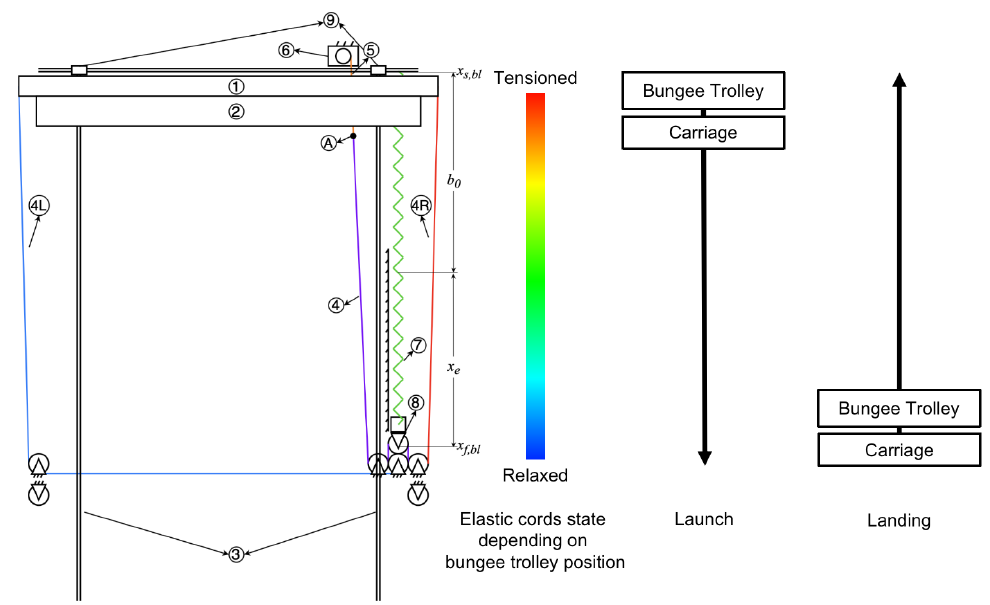
Figure 4. The top view of one end of the ElektRail with a BLLS (components described in the text).